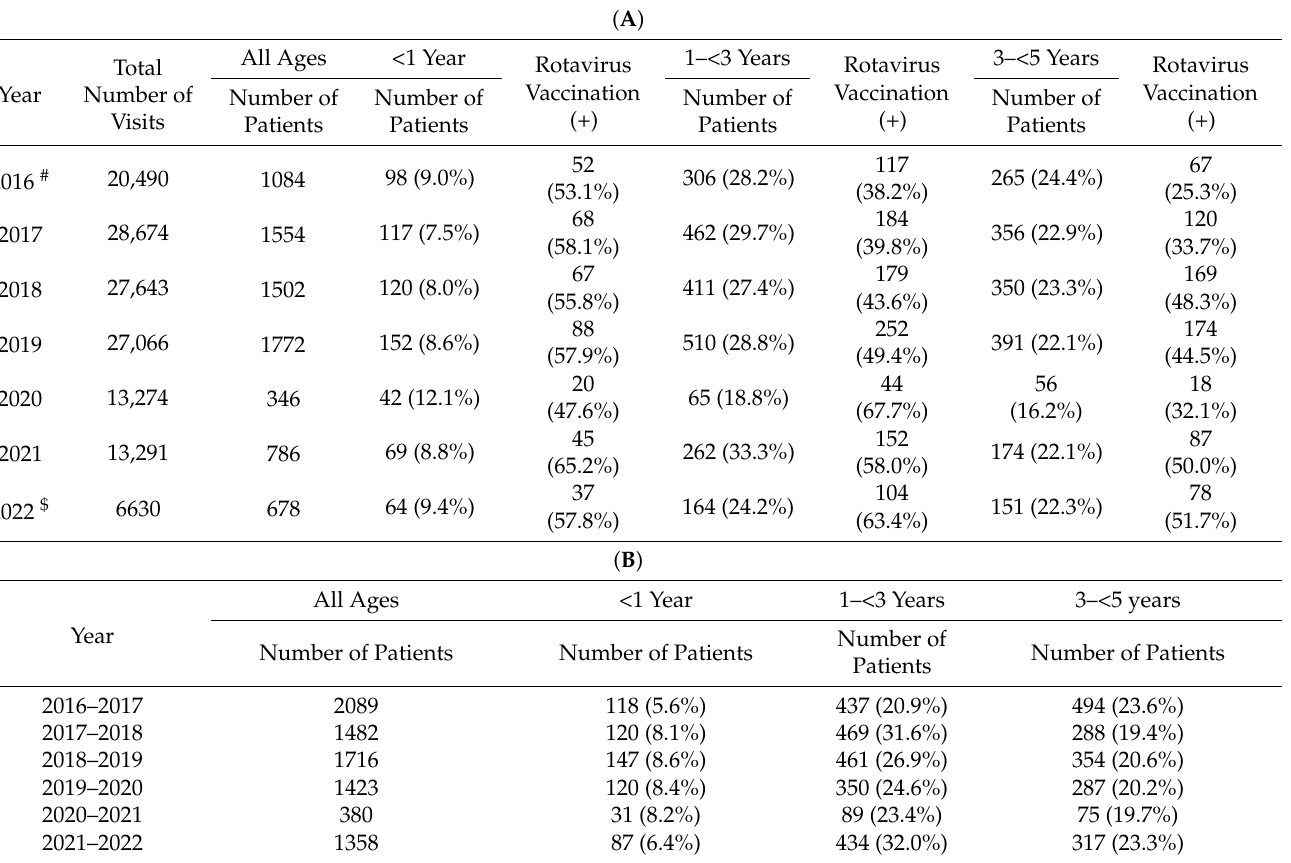
Table 1. (A) The annual number of patients and vaccination history of patients with acute gas- troenteritis who visited our emergency department during rotavirus seasons (March–June). (B) The annual number of patients with acute gastroenteritis who visited our emergency department during norovirus seasons